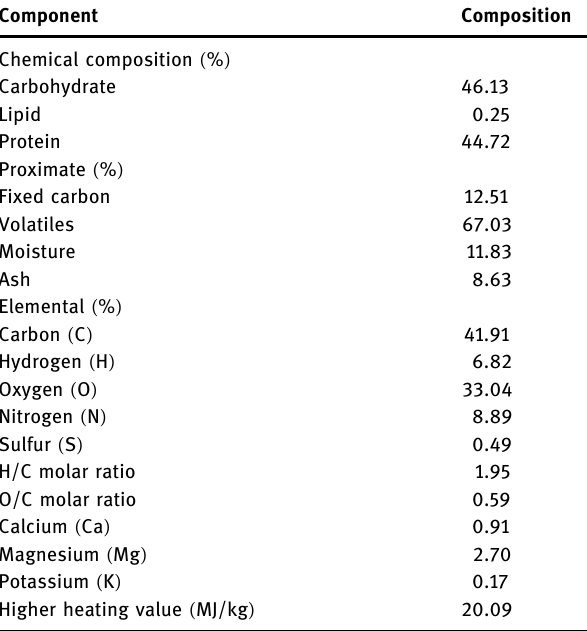
Table 1: Characteristics of microalgae Spirulina sp. [ 32